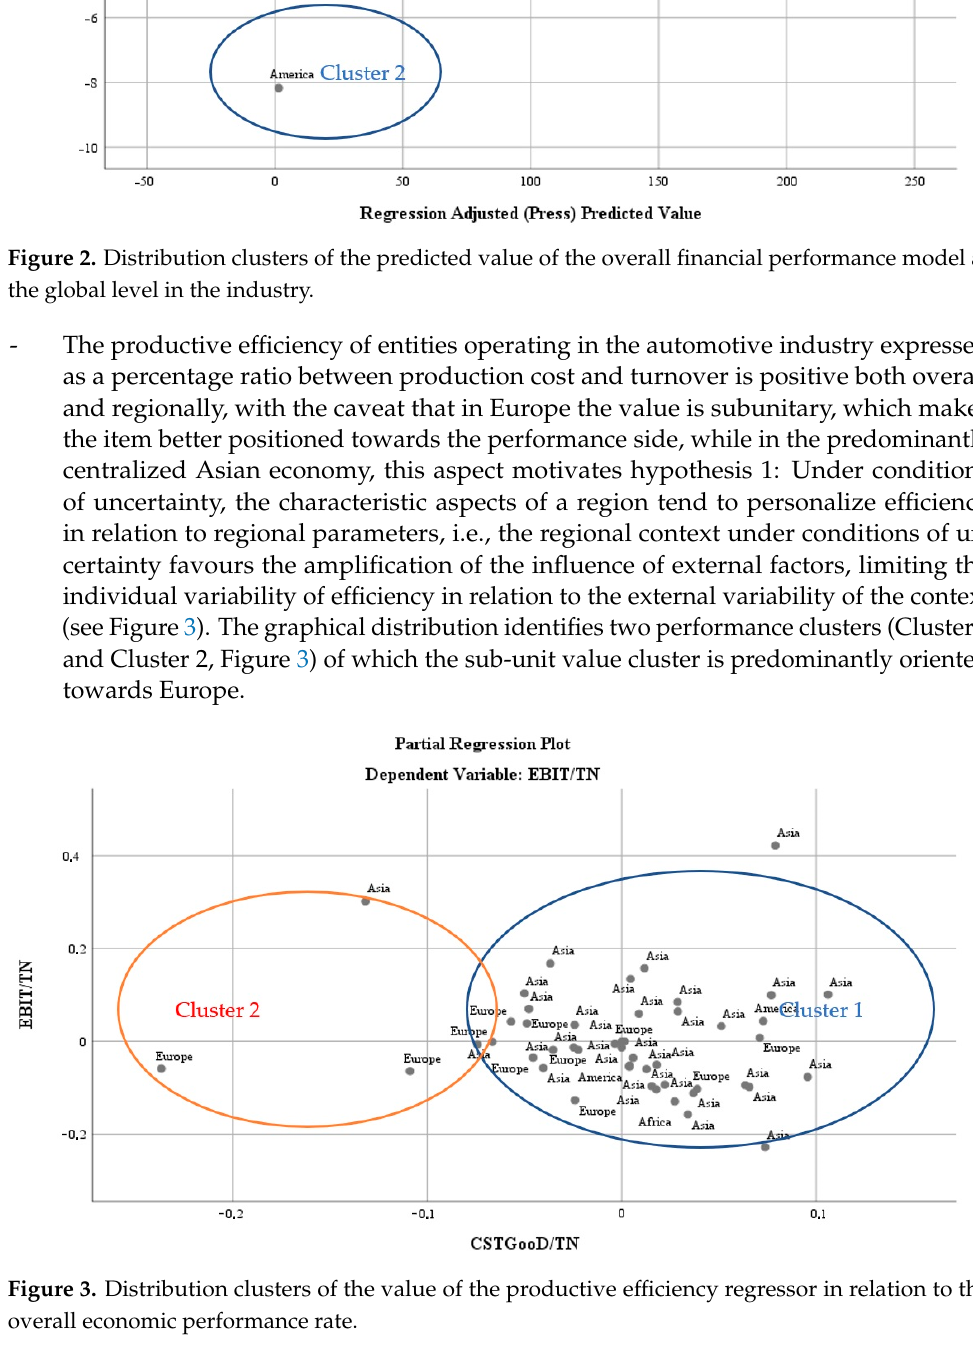
Figure 4. Distribution clusters of the value of the current asset utilisation efficiency regressor on the overall economic performance rate.